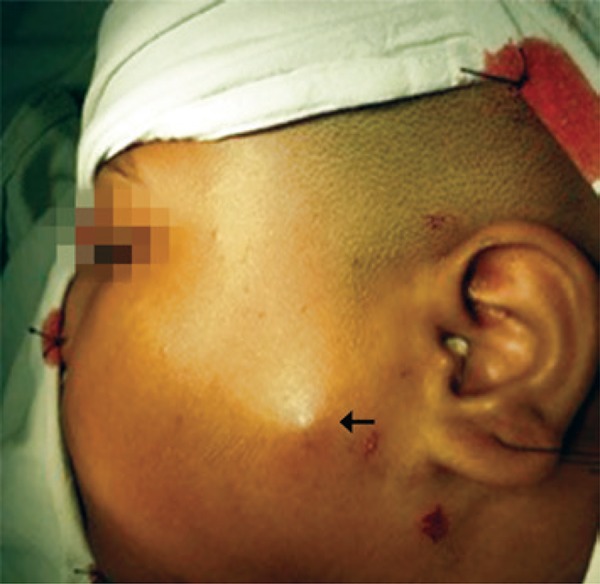
Imagem pré-operatória mostrando edema difuso na região pré-auricular esquerda produzindo impressão de massa na parótida. Nota-se “sinal de tenda” (seta). A pele apresenta-se tensa e esticada. Em exame detalhado, pode-se observar uma discreta tonalidade azulada sobre a lesão